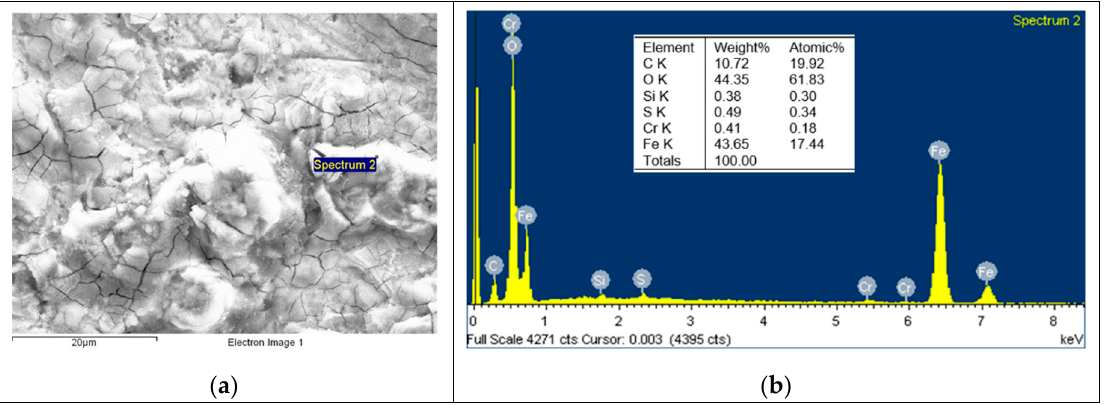
Figure 9. ( a ) SEM image and ( b ) EDS spectrum for discs tested against the PA46GN sample.